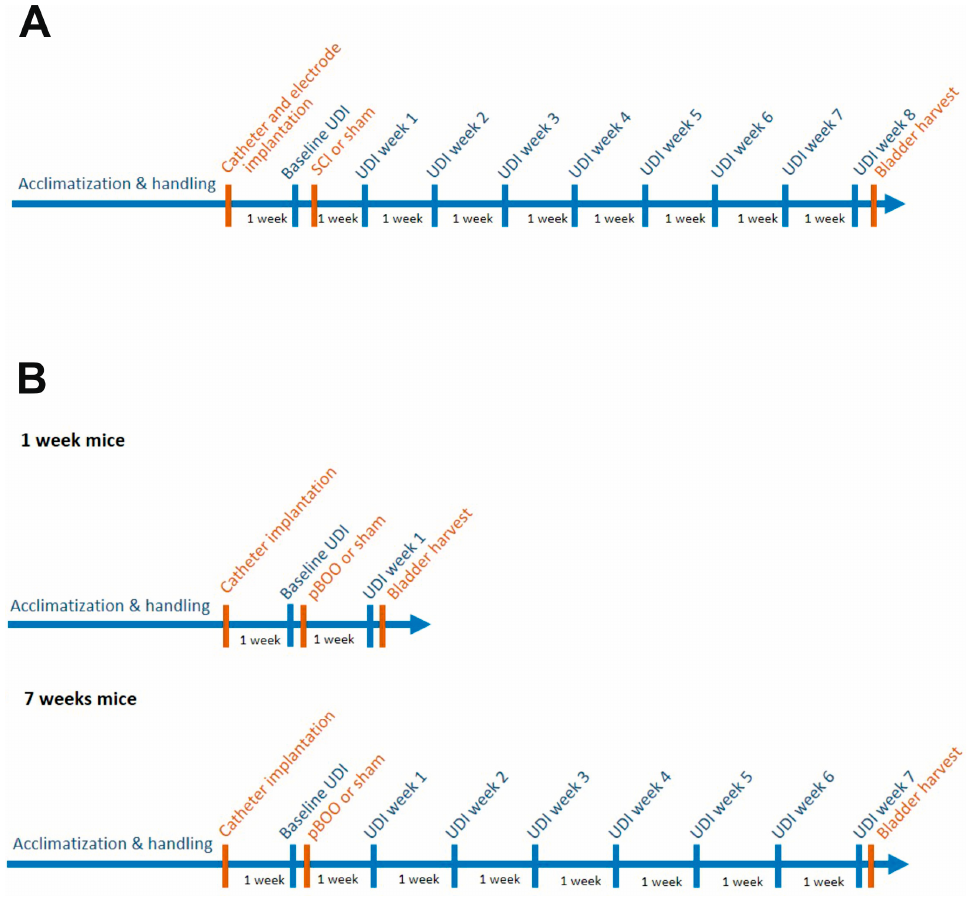
Figure 1. Study design. ( A ) SCI study, ( B ) pBOO study